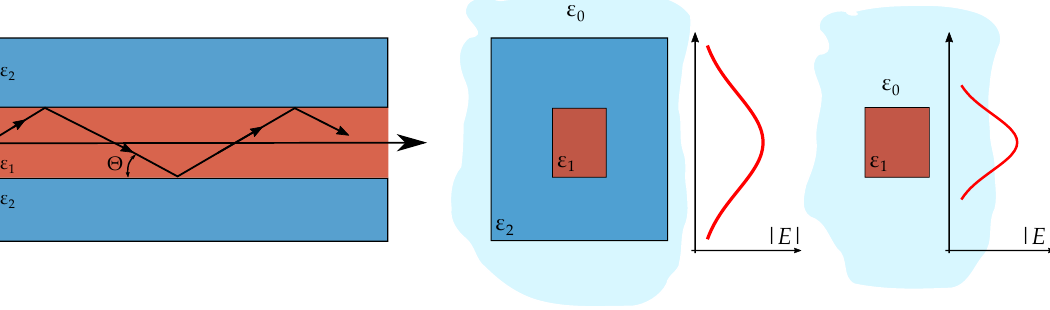
Figure 22. ( Left ) Schematic cross-section of a DW used for the geometric approach, with ε 1 > ε 2 > ε 0 . Cross-section of two common dielectric waveguide types: (Center) Step-index fiber with ε 1 > ε 2 and ( Right ) Subwavelength fiber. The principle E-field distributions for both types are depicted.